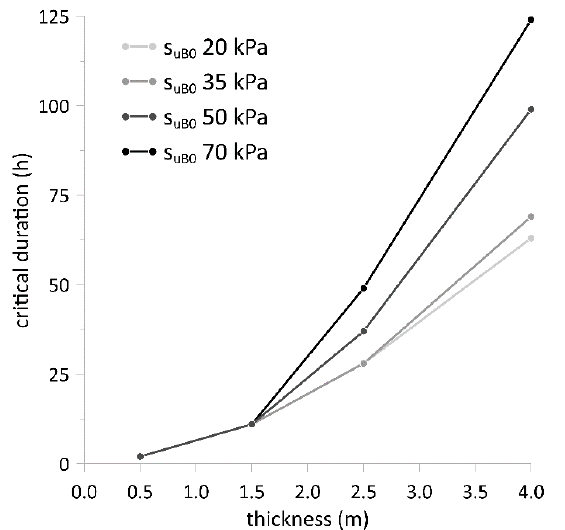
Figure 10. Results of set B analyses: critical duration against domain thickness computed for four different initial suction values.